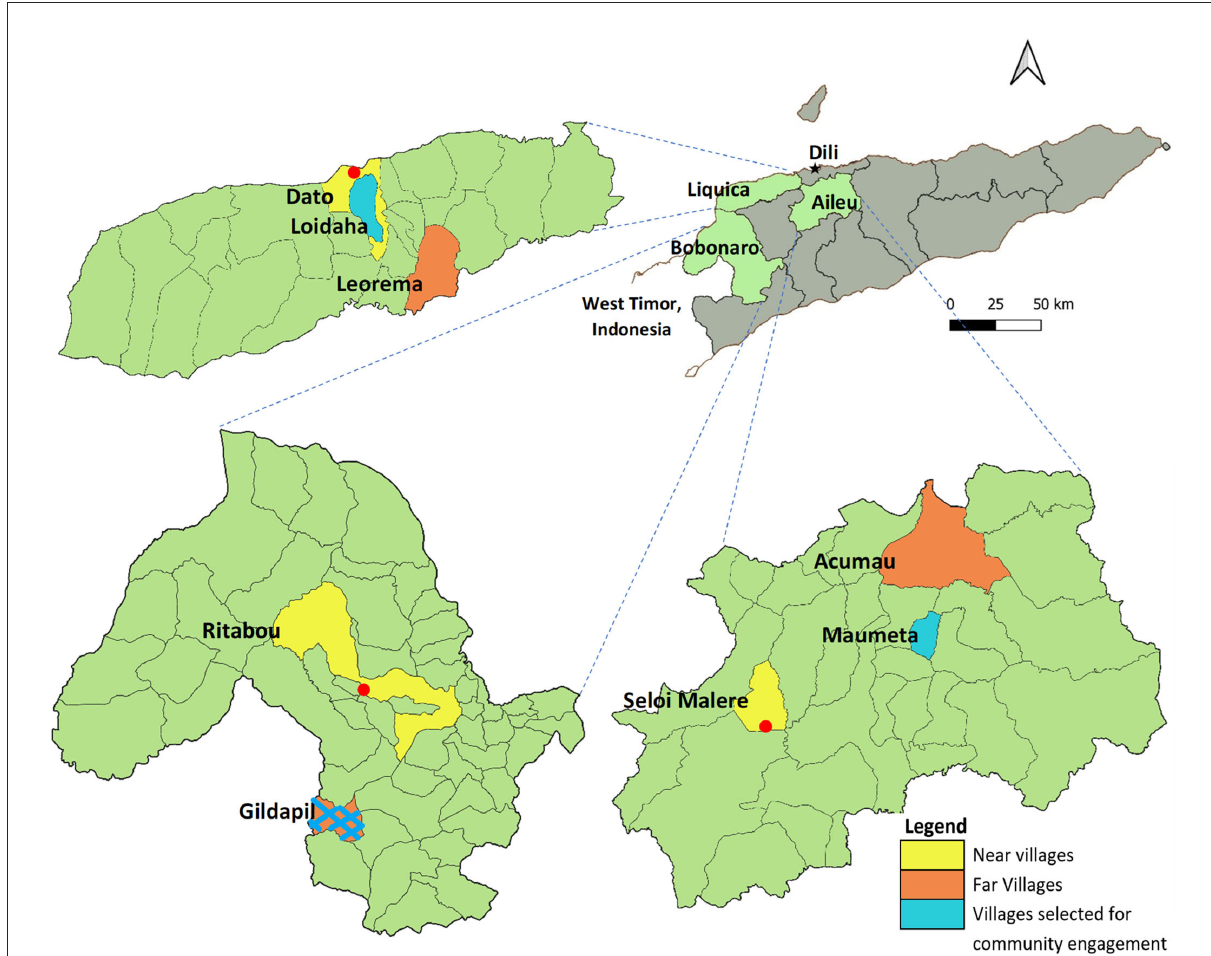
FIGURE1 Location of study villages and engagement villages. The red dots are municipal towns.